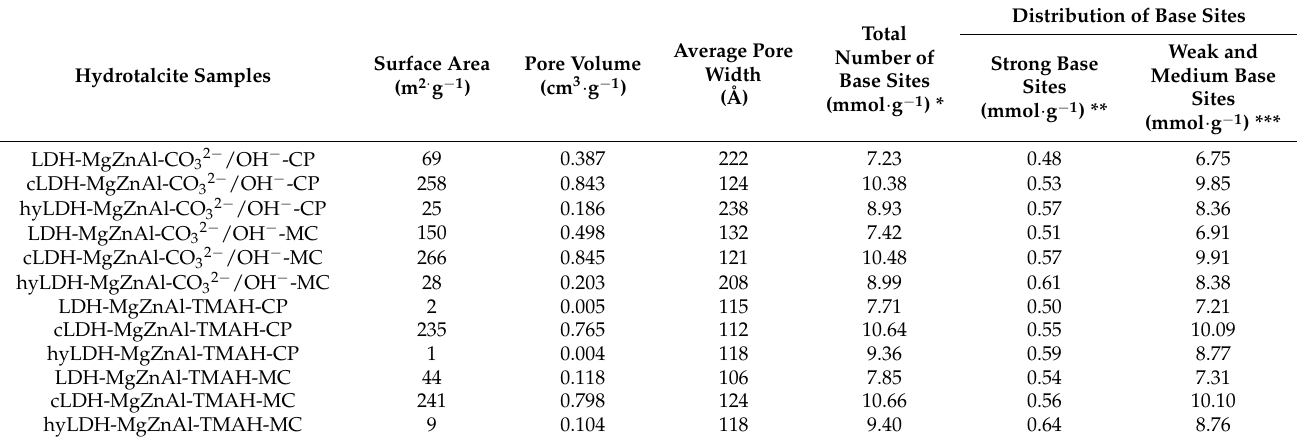
Table 2. The surface area and basicity of